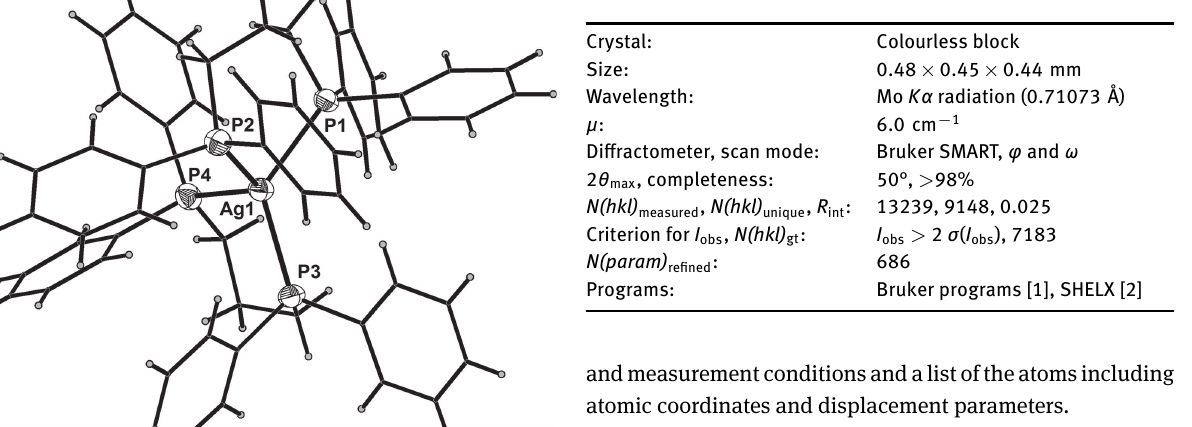
Table 1: Data collection and